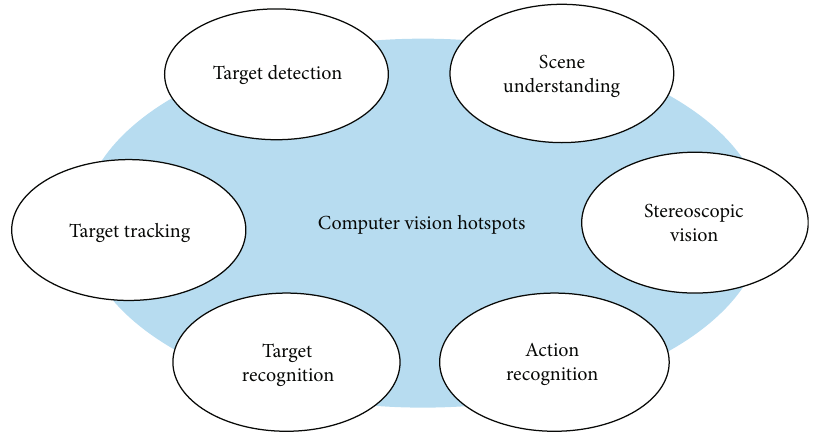
Figure 2: Computer vision application fi